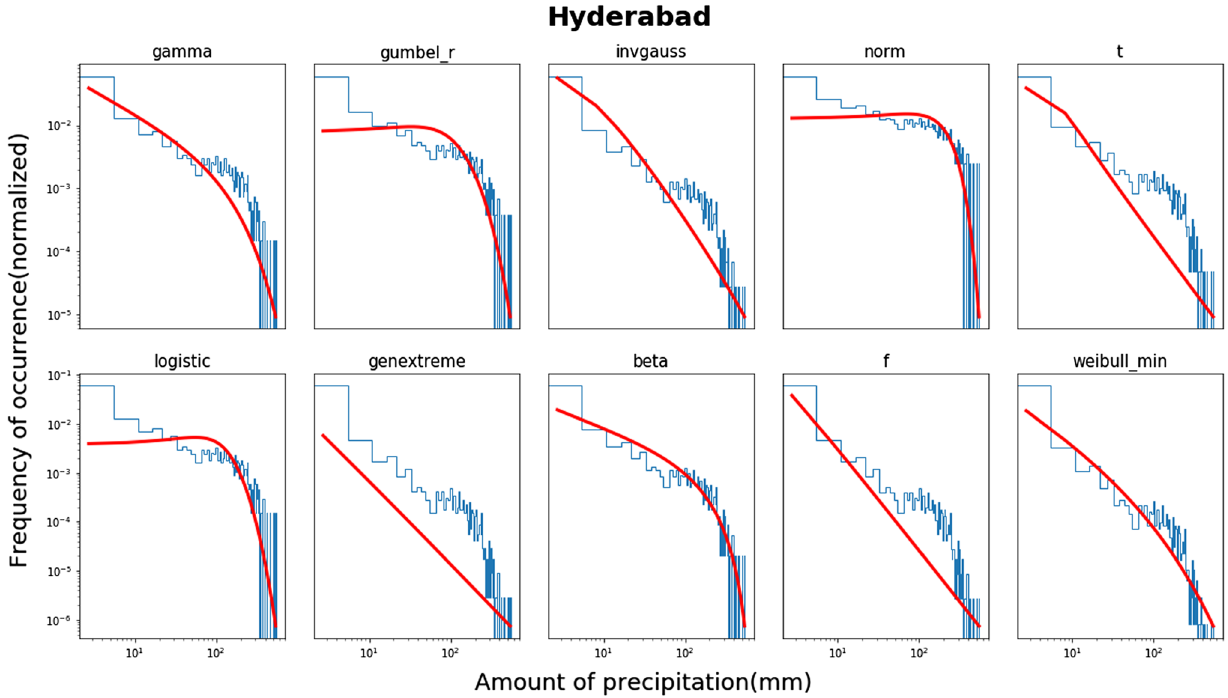
Fig. 3 Histogram of the monthly precipitate data at Hyderabad (blue lines) along with best fit for each of the 10 probability distributions func- tions considered